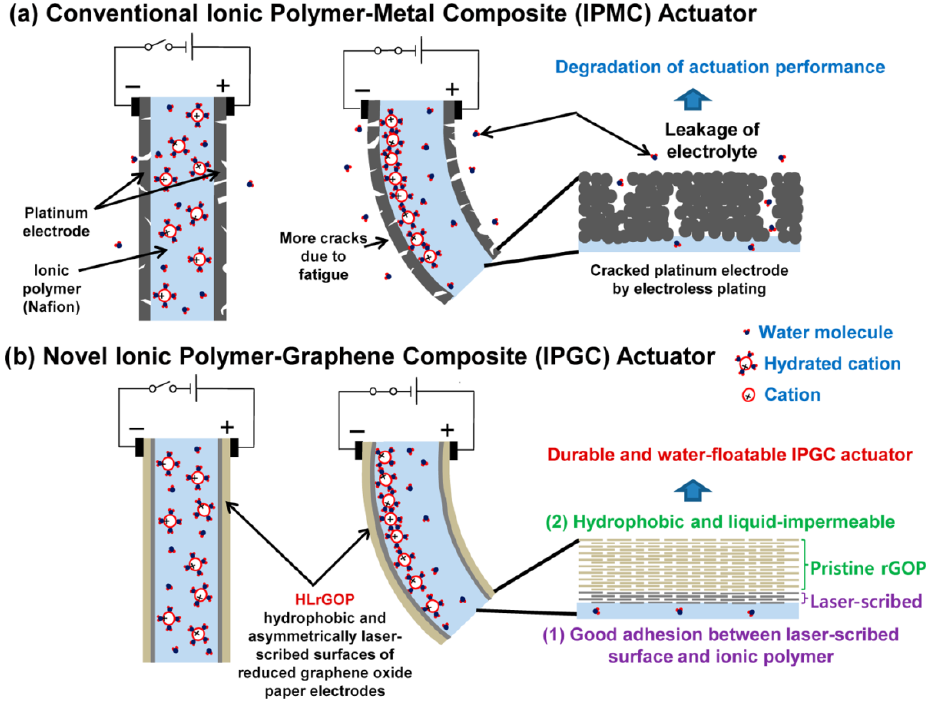
Figure 12. Actuators with different electrodes: ( a ) IPMC actuator, permeable for liquid; ( b ) IPGC actuator, allowing long-term operation. Reproduced from [37] with permission from American Chemical Society. Copyright 2014.